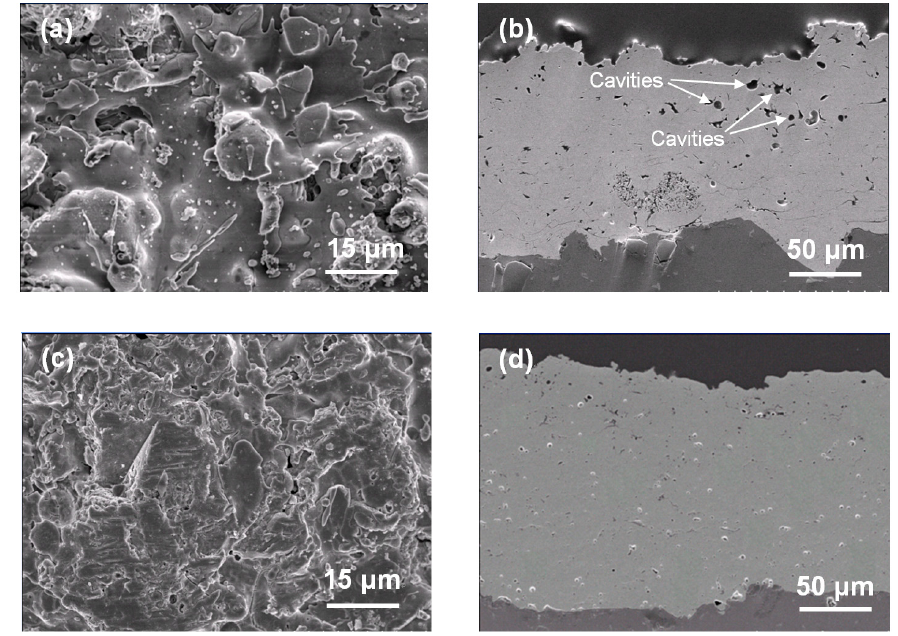
Figure 2. Surface and cross-sectional SEM images of ( a , b ) Y 2 O 3 and ( c , d ) YF 3 coating at plasma spray power of 15 kW.